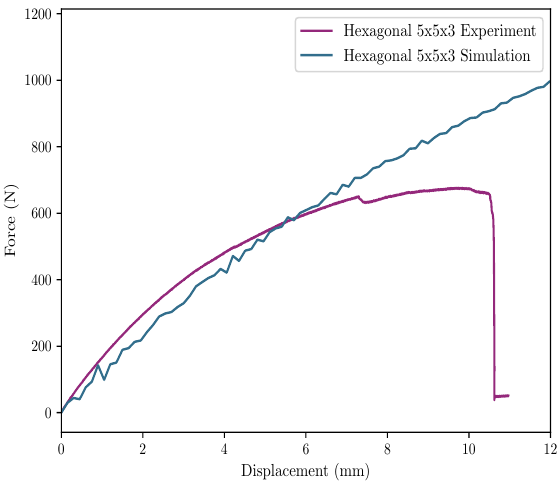
Figure 9. Tension Test of Hexagonal 5 × 5 × 3 mechanical tests show a linear behaviour and match with the simulation for both specimens. Then again for a higher number of unit cells the force progression is higher. At a displacement of around 10 mm a force plateau is reached and at a later point the densification starts, which again happens earlier for Octet 4 × 4 × 4 .